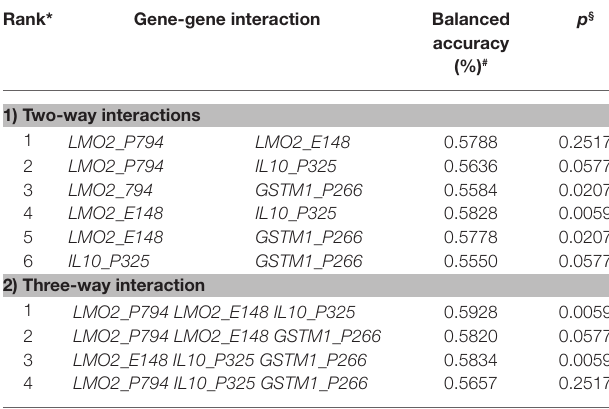
TABLE 4 | Interactions among genes with higher CG contents in relation to asthma diagnosed at 6 years of age in MDR analyses. Rank*